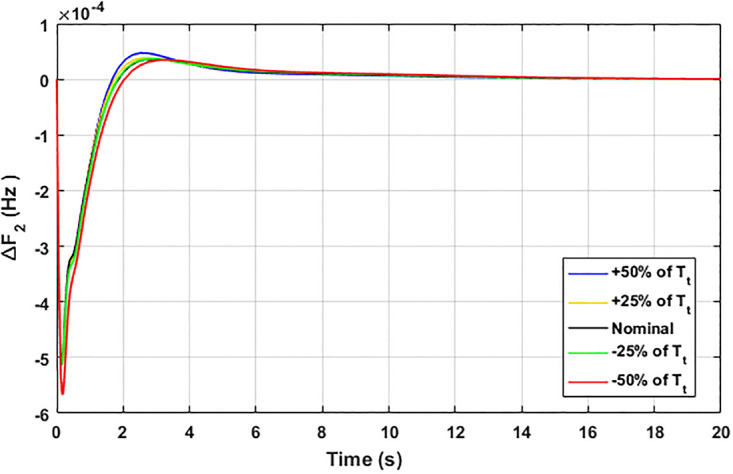
Results for variation in Tt with ΔF2.